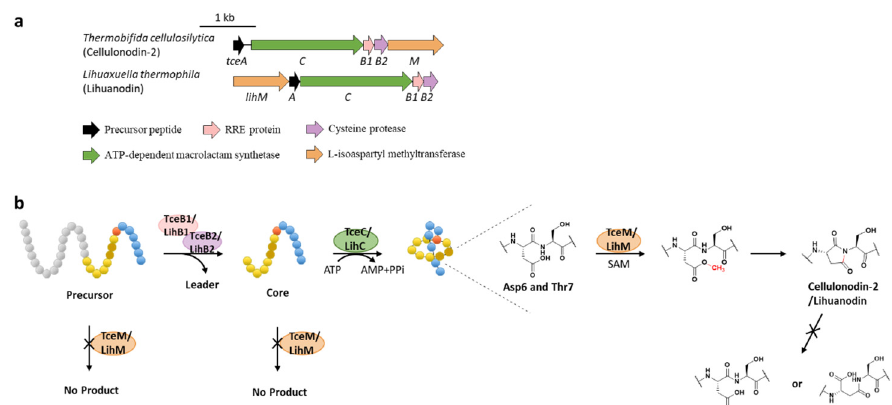
Figure 9. The BGCs ( a ) and biosynthetic pathways ( b ) of cellulonodin-2 and lihuanodin. Zoomed- in images of the Asp6 and Thr7 residues in the threaded lasso peptides are provided for further illustration. Both TceM and LihM could only recognize the threaded lasso peptides as substrates.